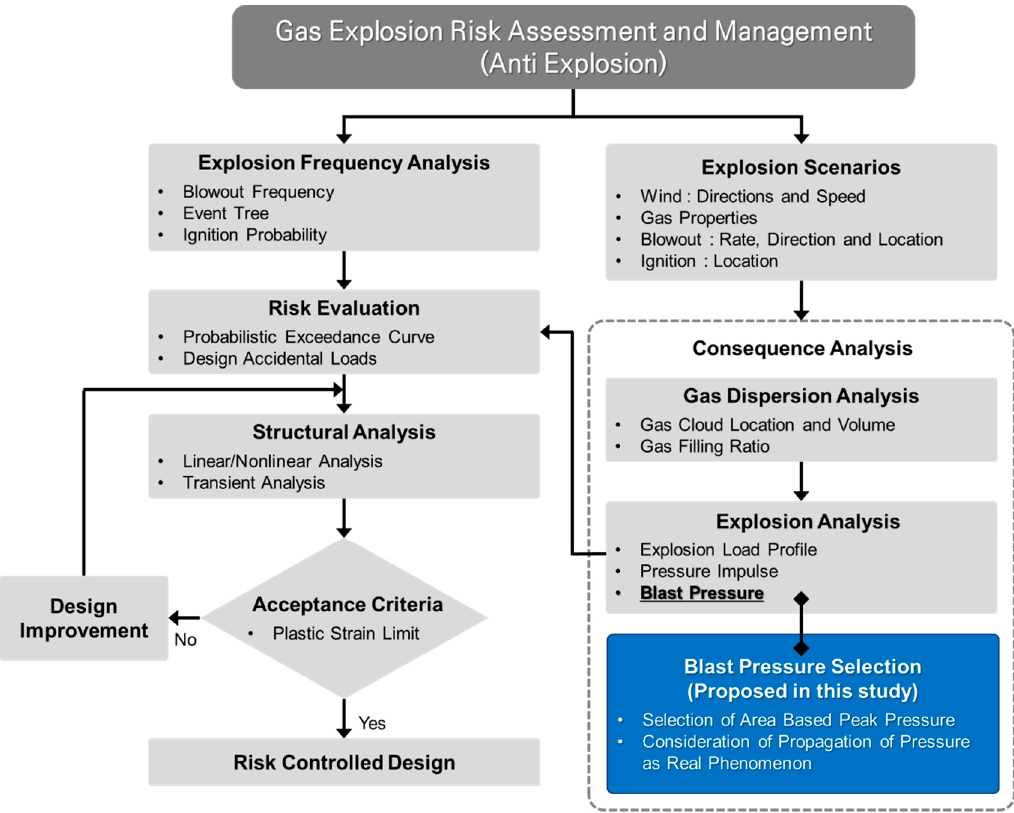
Figure 3. Gas explosion risk assessment and management (modified from [17]) including proposed methodology for blast pressure application.